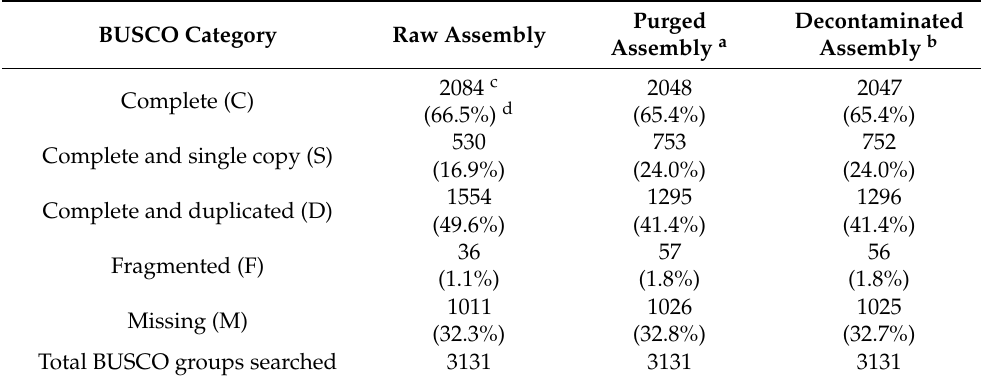
Table 2. Genome summary statistics and benchmarking universal single-copy ortholog (BUSCO) score estimation for raw, purged, and decontaminated Pratylenchus scribneri genome assemblies obtained using DNA extraction Method 2.